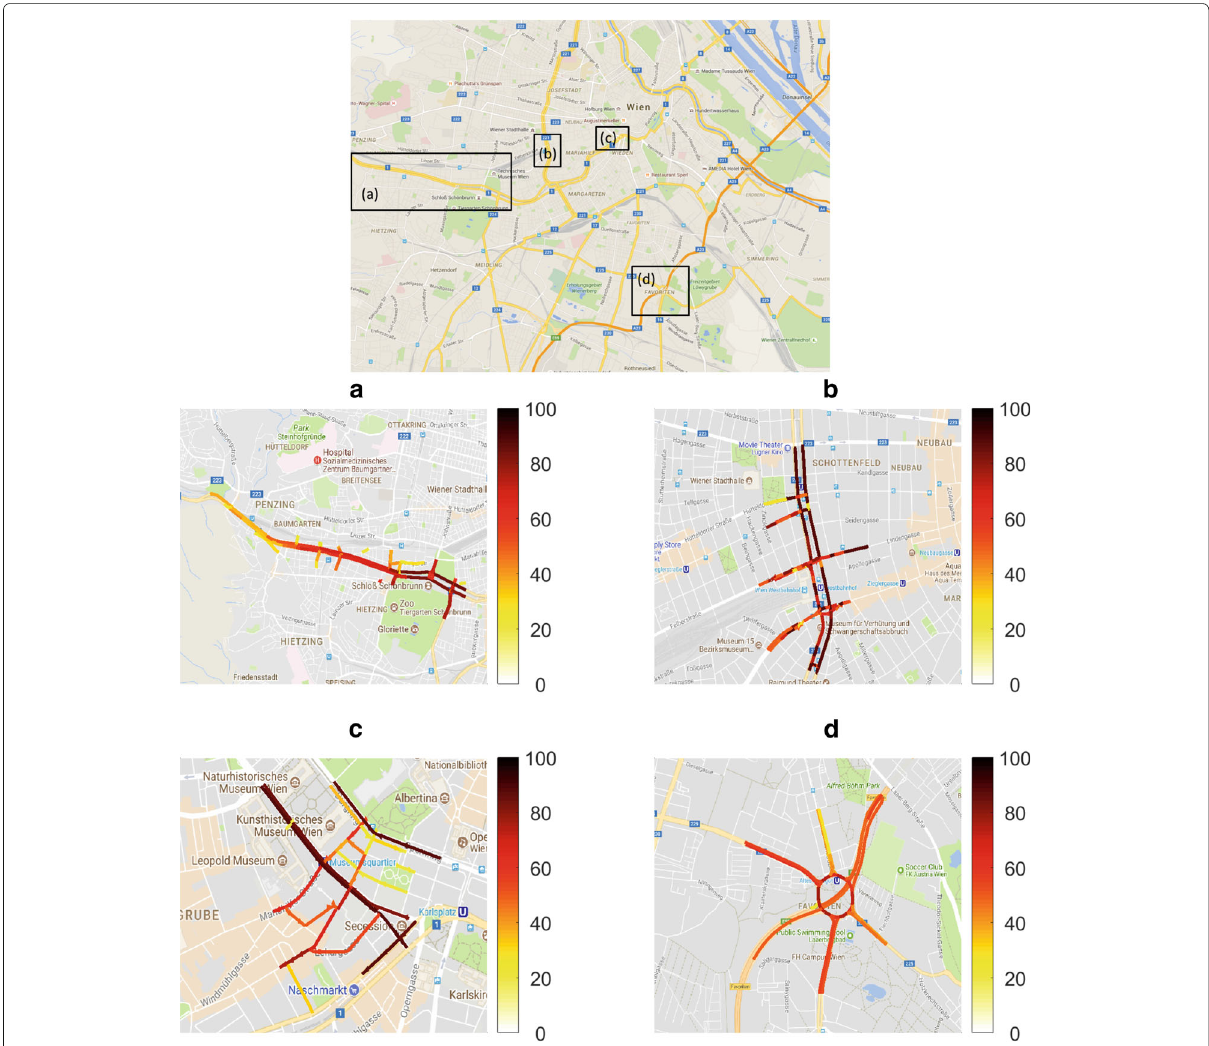
Fig. 1 Location of the test sites. a Hietzing, b Westbahnhof, c Ring, d Südosttangente. The colour of the arrows indicates for a given link the percentage of time intervals for which at least one observation is obtained (white=0%, orange = 50%, black = 100%). Background image: ©Google maps